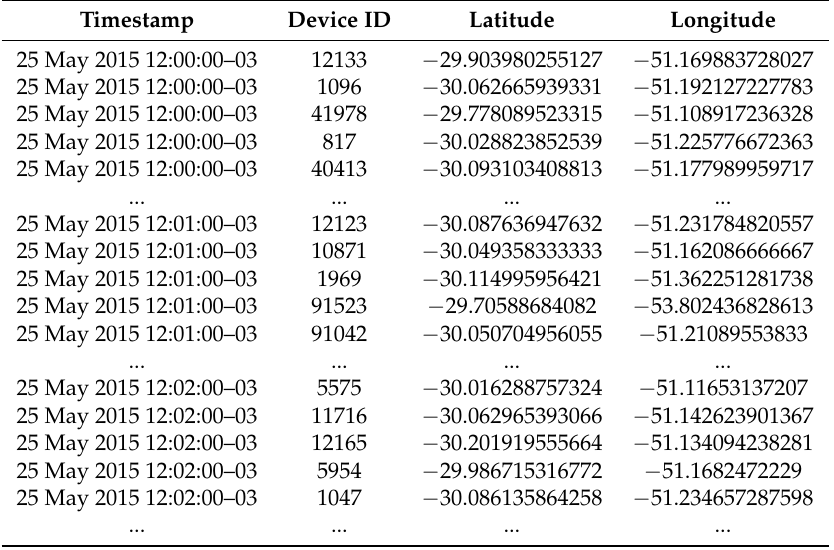
Table 11. Sampling extracted from simulated